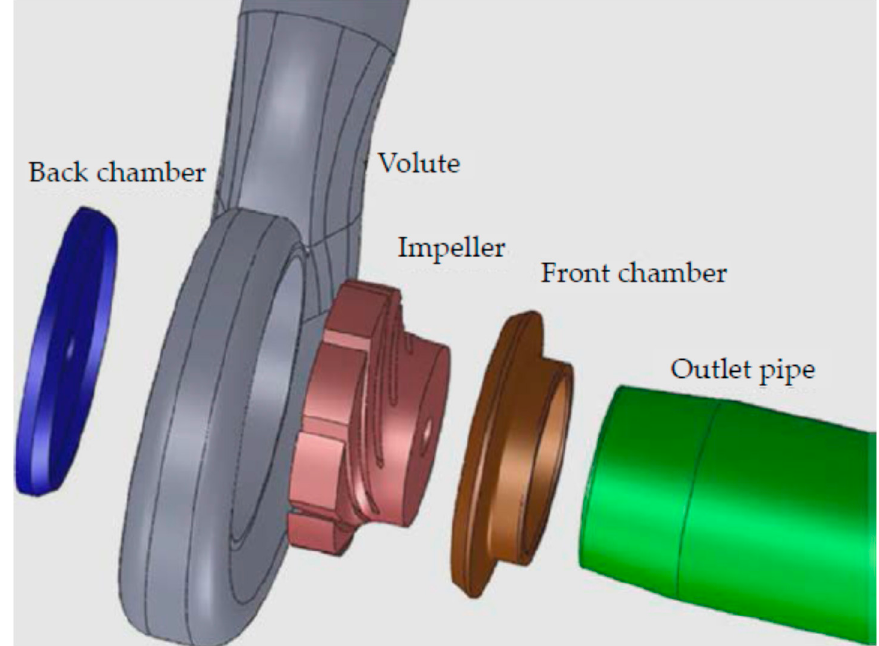
Figure 11. Different flow domains of PAT.